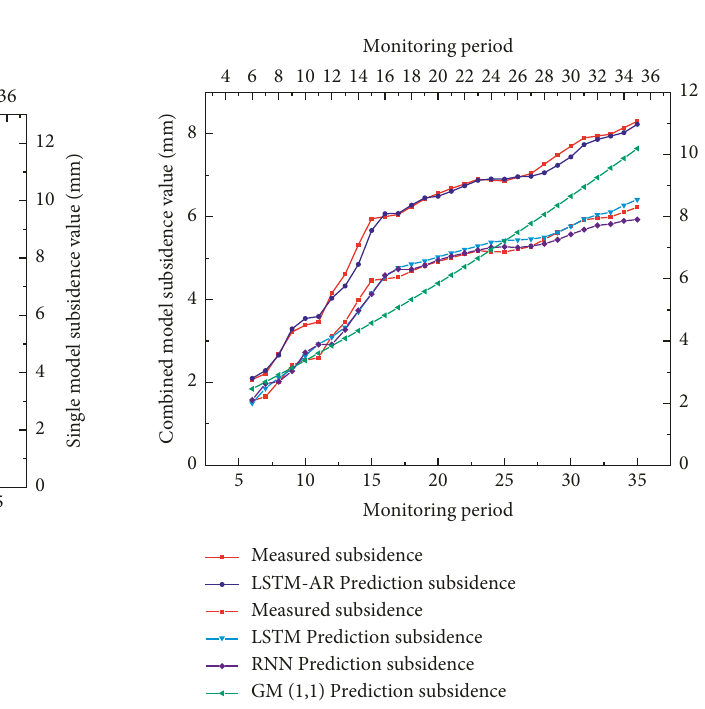
Figure 10: KQ4-Z prediction result.